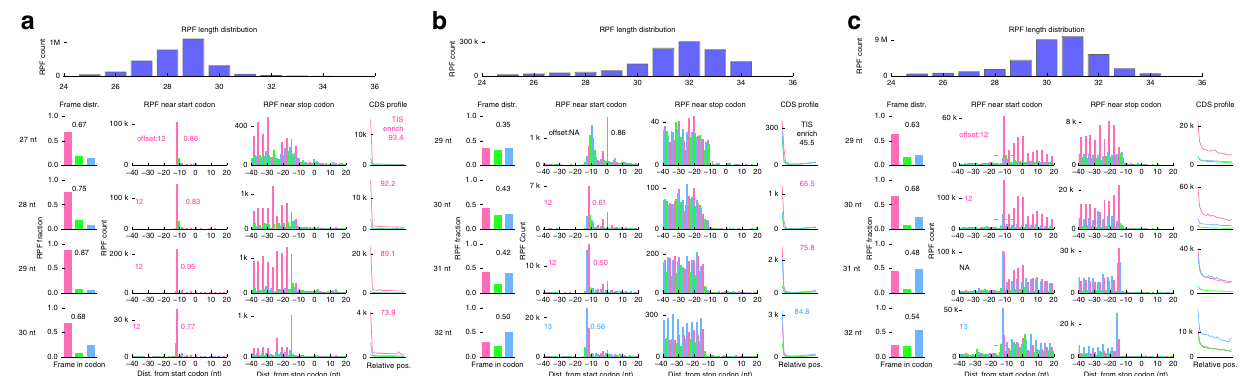
Fig. 2 Quality control of TI-seq and rRibo-seq data. Quality control with Ribo-TISH for two TI-seq data sets generated using a LTM or b Harr, and c one rRibo- seq data set generated using CHX. Upper panel: length distribution of RPFs uniquely mapped to annotated protein-coding regions. Lower panel: different quality pro fi les/metrics for RPFs uniquely mapped to annotated protein-coding regions. The data corresponding to the fi rst, second and third reading frame are colored in pink, light green and sky blue, respectively. Each row shows the RPFs with indicated length. Column 1: distribution of RPF 5 ′ end across three reading frames in all annotated codons; showing the fraction of RPF counts from dominant reading frame ( f d ). Column 2: distribution of RPF 5 ′ end count near annotated TISs; showing estimated P-site offset and the ratio ( f t ) between the RPF counts at the annotated TISs and the sum of the RPF counts near the annotated TISs (from − 1 to +1 relative to the annotated TISs) after P-site offset correction. Column 3: distribution of RPF 5 ′ end count near annotated stop codon. Column 4: RPF count pro fi le throughout protein-coding regions across three reading frames; showing TIS enrichment score for TI-seq